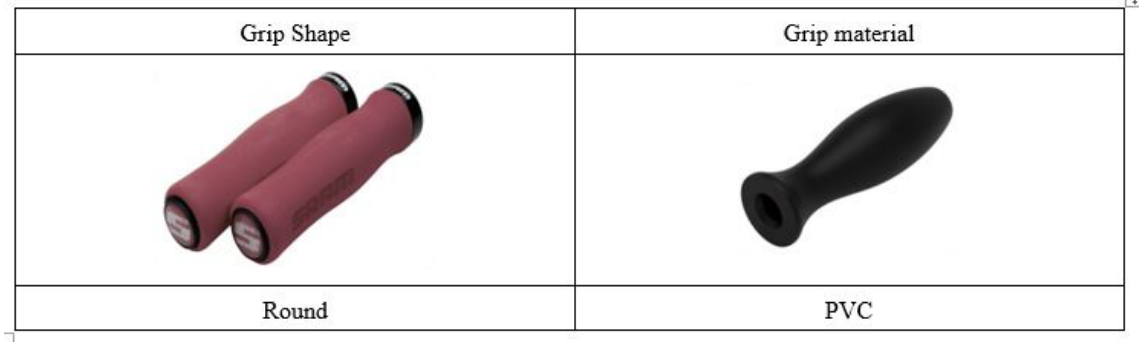
Figure 2. Grip shape and grip